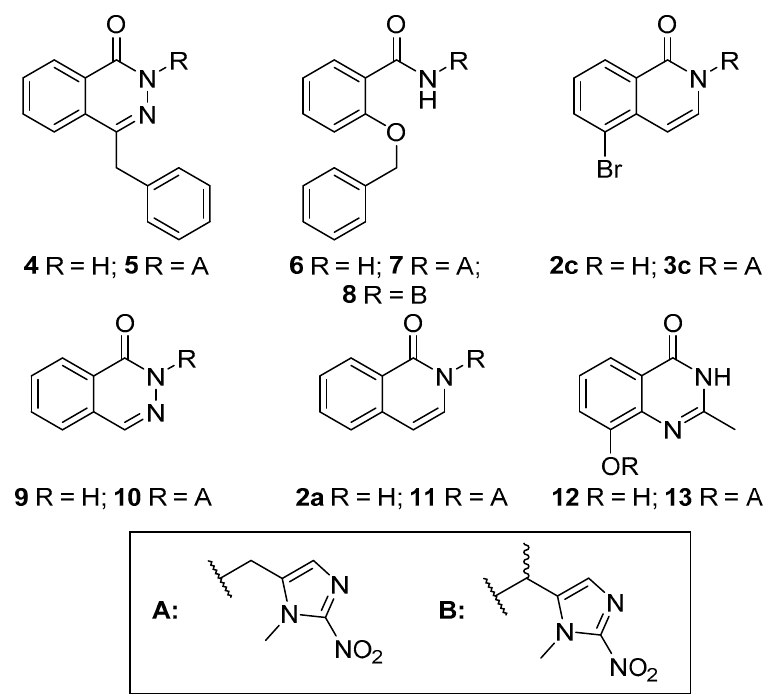
Figure 3. Poly(ADP-ribose)polymerase inhibitor (PARPi) ( 2a , 2c , 4 , 6 , 9 and 12 ) and corresponding model hypoxia-activated prodrugs (HAPs) ( 3c , 5 , 7 , 8 , 10 , 11 and 13 ).